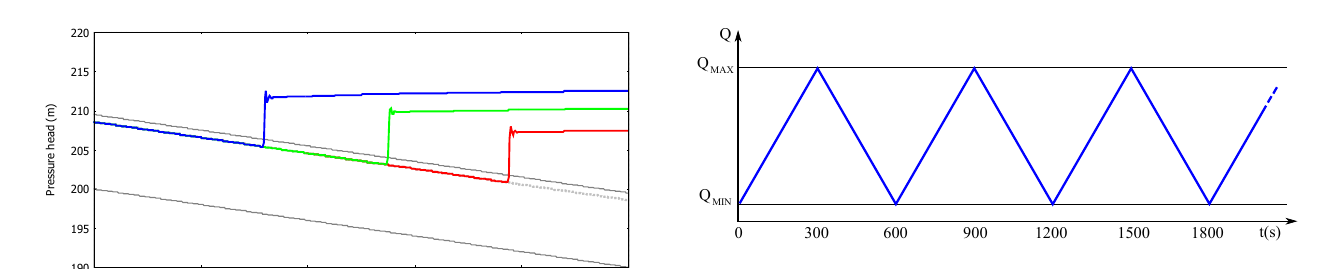
Figure 11. Triangular inlet hydrograph in the pipe 1. Figure 9. Shockwave propagation in transient mixed flow at t = 100 s (red), t = 200 s (green) and t = 300 s (blue).